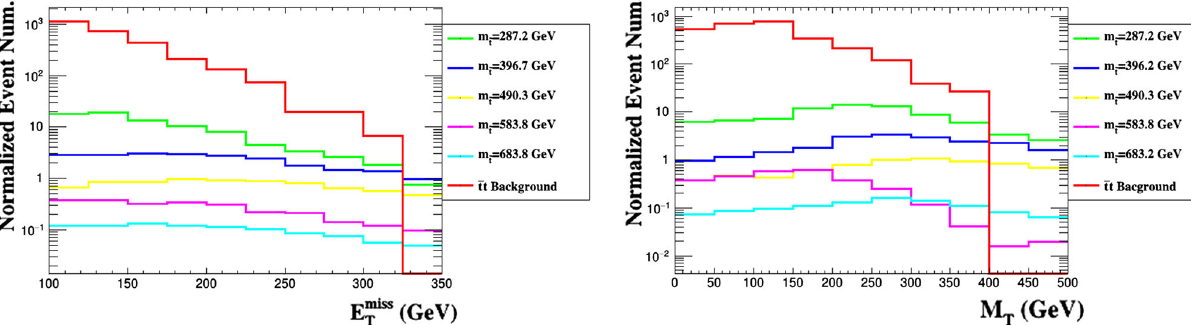
and M T for the signals and background. The cut on E miss T